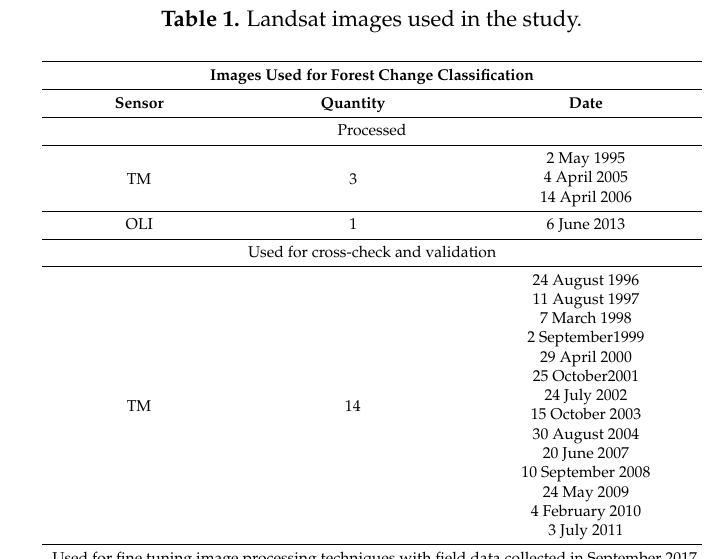
Table 1 . Landsat images used in the study.